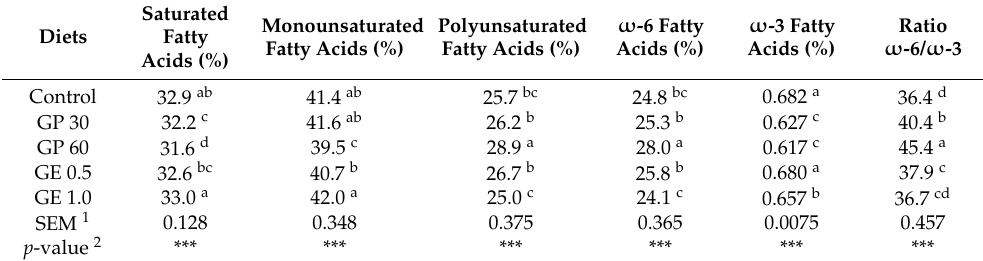
Table 6. Effect of grape pomace (GP) and grape extract (GE) at different dietary concentrations (g/kg) on the yolk fatty acid profile in eggs of 50- to 54-week-old laying hens.